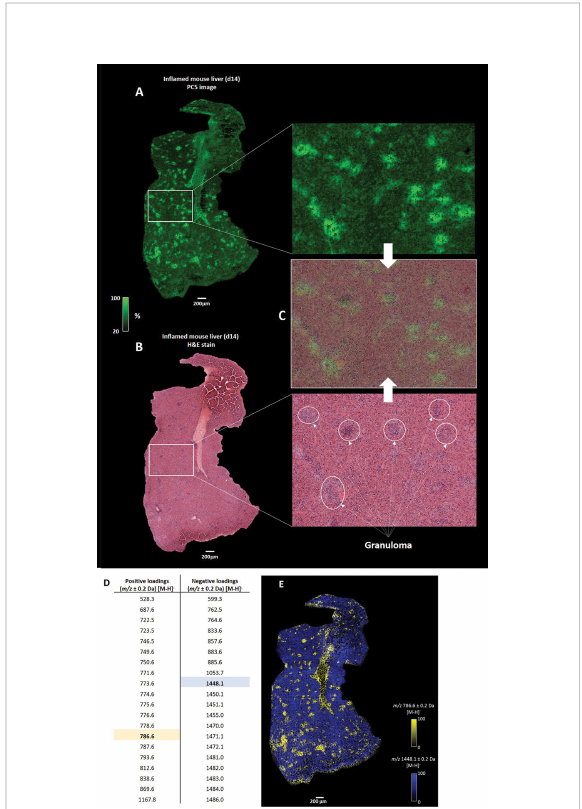
FIGURE 3 Integration of MSI and histopathology. (A) Principal component analysis (PCA) score image of the fi fth principal component (PC5) shows the variance of correlated spatially-resolved lipid masses from a d14 L. donovani - infected mouse liver. (B) Post MALDI-MSI H&E staining of the tissue allows the histopathological annotation of granulomas. (C) Co-registration of the H&E-stained and the PC5 image reveals that lipid masses, correlated with the bright green regions, overlap with observed granulomas. Only a selection of granulomas are highlighted (D) Top 20 positive and negative loadings from the PC5 images, which represent the correlated lipid masses to the bright green (positive loadings) and dark green (negative loadings) regions. (E) Overlaid image of the spatial distribution of the relative abundance of m/z 786.6 (highlighted in yellow in D ) and m/z 1448.1 (highlighted in blue in D